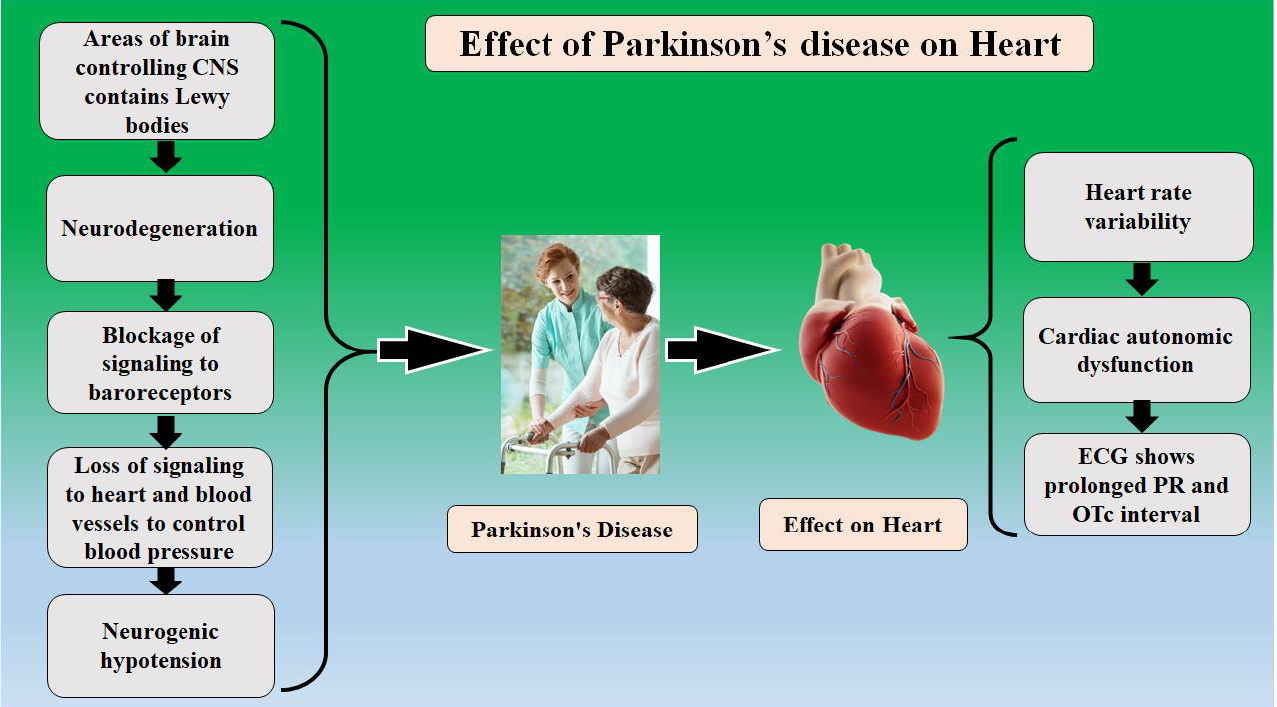
Figure 4. The relation between Parkinson’s disease and Heart. Table 1 represents various attributes that relate to the link between PD and CVD. Orthostatic hypotension and cardiac abnormalities are the most prevalent medical issue among the Table 1. The studies show the relation between Parkinson’s and Cardiovascular disease.